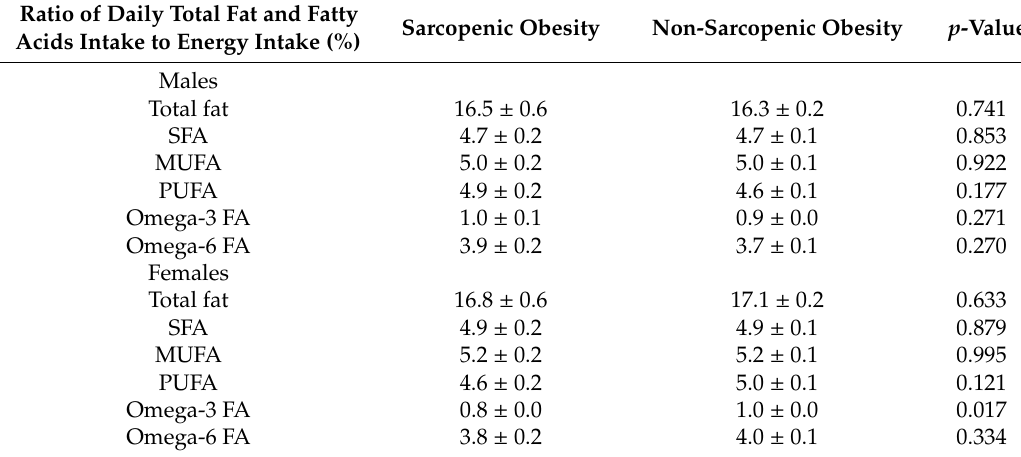
Table 3. Ratio of daily total fat and fatty acids intake to energy intake according to the presence of sarcopenic obesity.